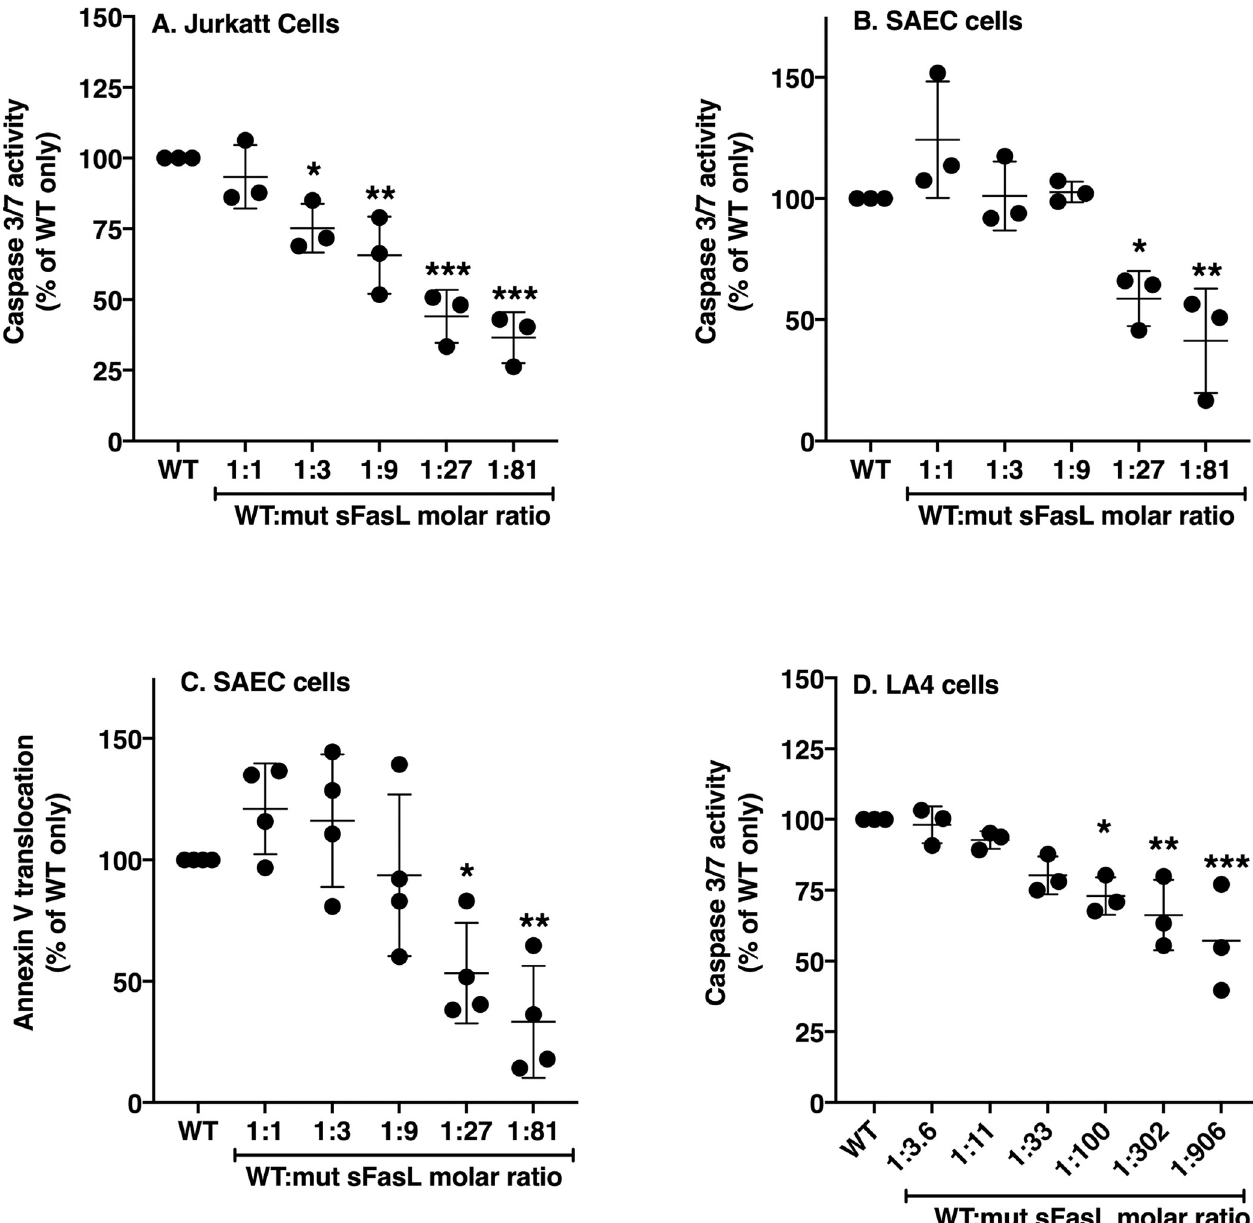
Fig 3. The mut-sFasL has inhibitory properties. Highly Fas-sensitive Jurkat cells (A), primary human lung small airway epithelial cells (SAEC, B) or murine lung epithelial cells (LA4, D) were incubated with serial dilutions of mutated FasL, (mut-sFasL). The 8-site mutated sFasL caused a dose-dependent inhibition of wild type sFasL activity in Jurkat cells (A). The human lung epithelial cells (SAEC) and murine lung epithelial cells (LA4) were less sensitive to WT sFasL, but an inhibitory effect of the mutant protein was detected (B and D). As a confirmatory test, the experiment was repeated using SAEC and an annexin-V translocation assay (C). WT = wild type only (no mutant). Results show data from three or four separate experiments, each performed in duplicate. Each dot represents individual data, lines represent means ± SD. � = P < 0.05; �� = P < 0.01, ��� P < 0.001 when compared to WT only using one way ANOVA with Sidak’s post hoc